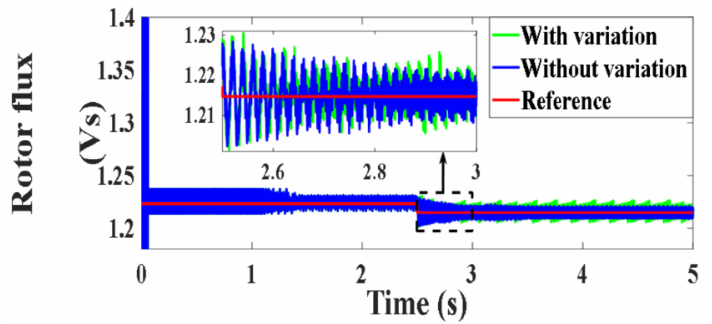
Figure 100. Rotor flux under PVC